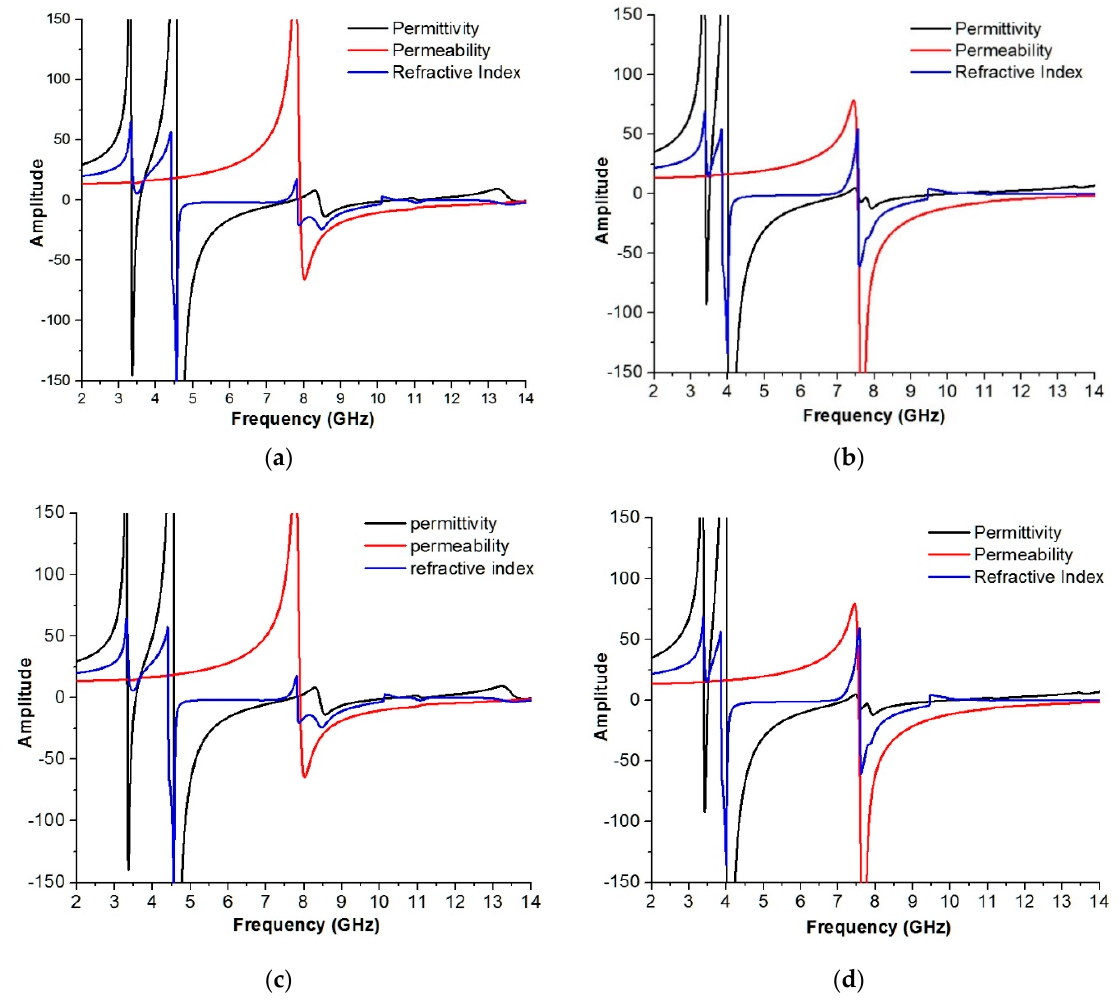
Figure 12. Amplitude of the permittivity, permeability and refractive index at: ( a ) 0°, ( b ) 90°, ( c ) 180°, ( d ) 270° rotations of the 3 × 3 array structure. Table 5. Real values of ε , µ and n at 9.20